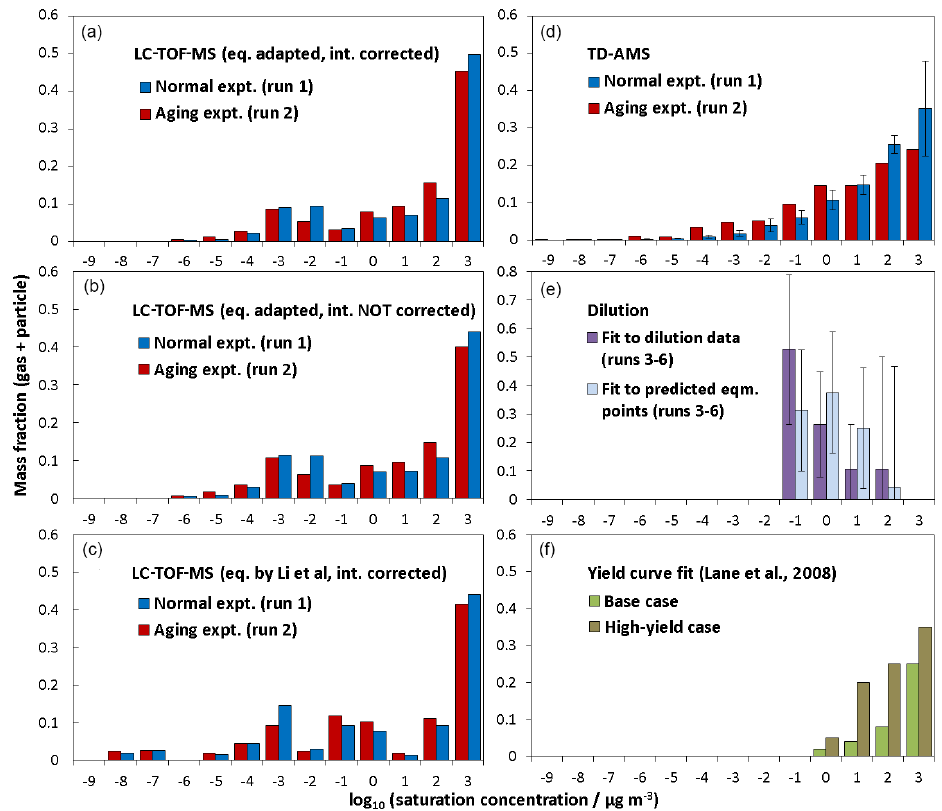
Figure 4. Volatility distributions determined for products from TMB using (a) LC-TOF-MS results, (b) LC-TOF-MS results obtained without intensity correction, (c) LC-TOF-MS results obtained using equation by Li et al. (2016) for saturation concentration calculations, (d) TD- AMS results, (e) dilution results, and (f) results of previous yield curve